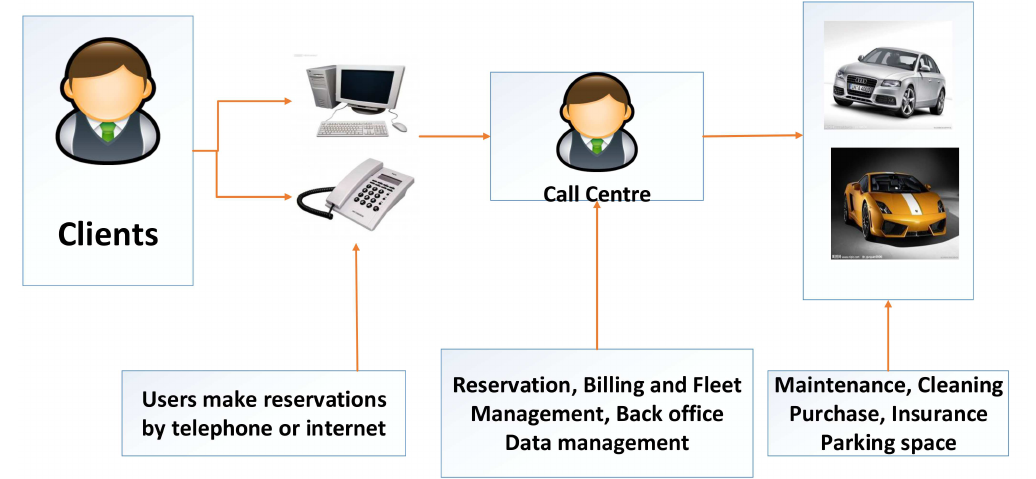
Figure 3. The architecture of a typical car-sharing organization (CSO)